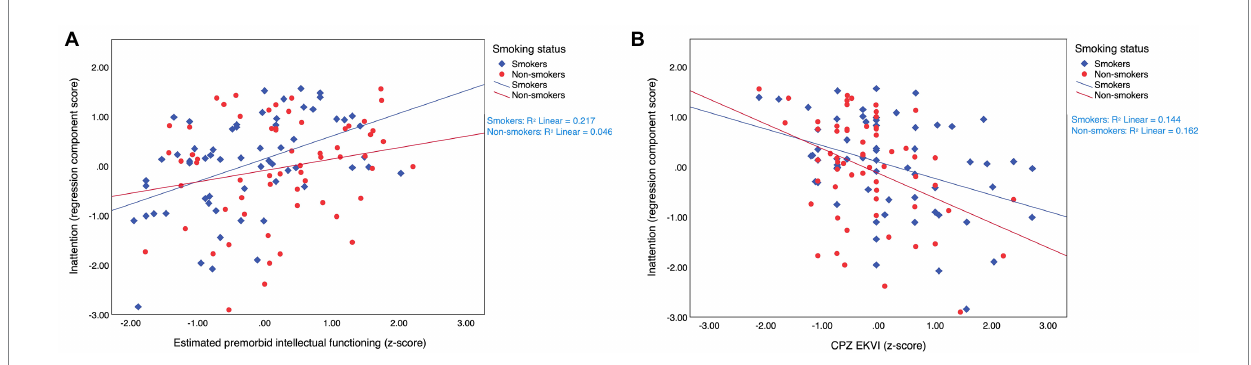
FIGURE 1 Estimated premorbid intellectual functioning (A) and antipsychotic medication dosage (B) affected inattention component scores approximately equally in smokers ( N = 61) and non-smokers ( N = 61) with SSDs. SSDs, schizophrenia spectrum disorders; CPZ EKVI, antipsychotic medication dosage in chlorpromazine equivalents.